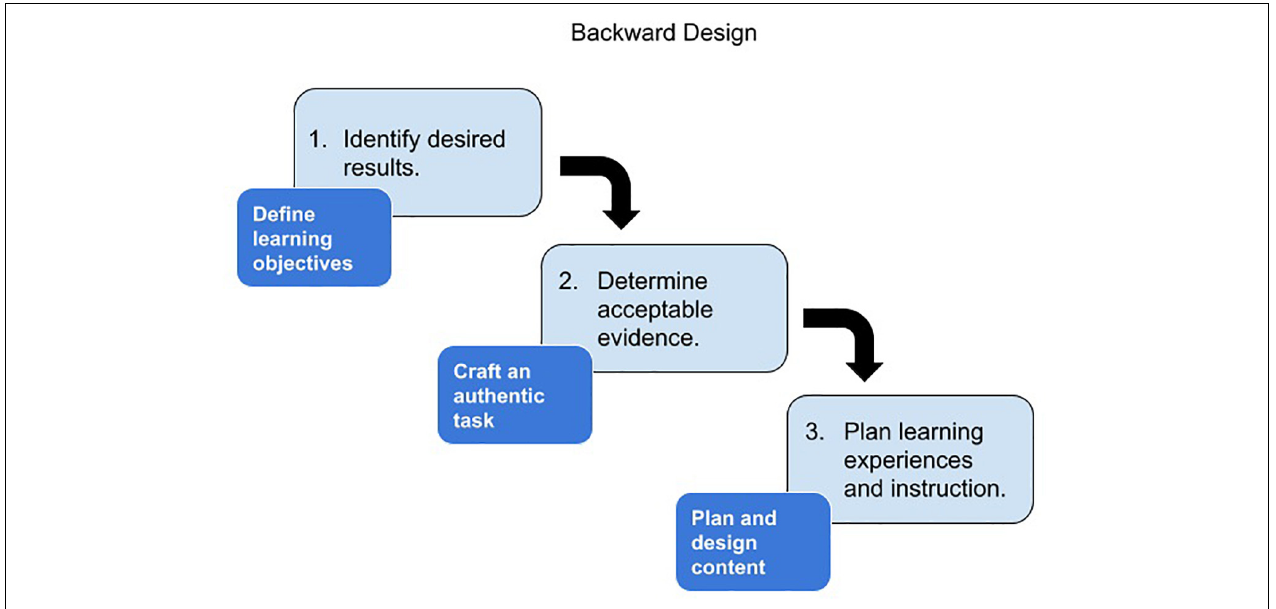
FIGURE 1 | Backward design model used to develop HydroLearn